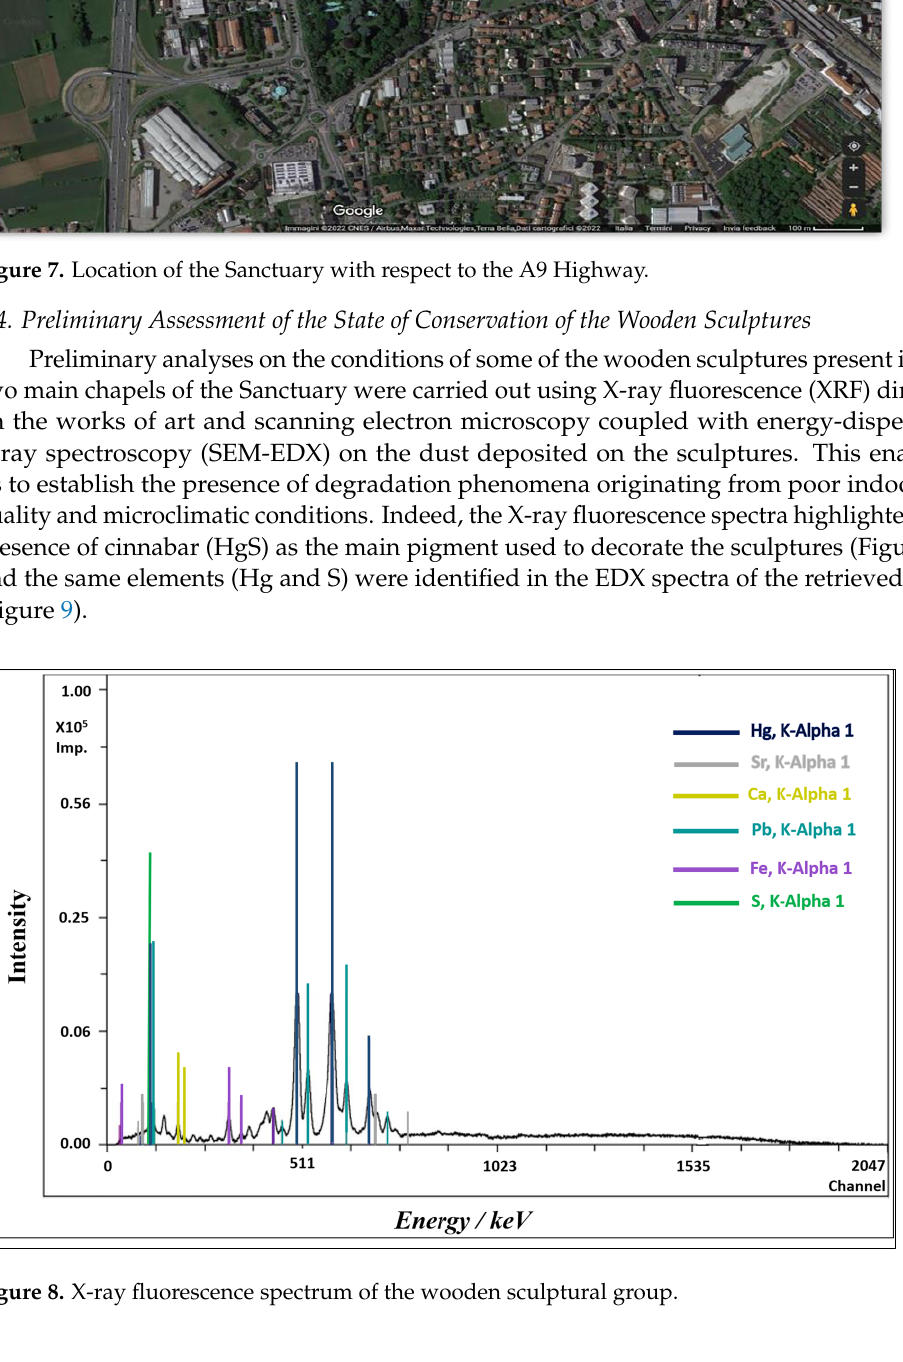
Figure 9. ( a ) SEM image of the dust deposited on the wooden sculptures (area = 0.80 mm × 0.60 mm, 400× magnification). ( b ) EDX spectrum of the image presented in ( a ). ( c ) Point image of the dust deposited on the wooden sculptures (Area = 0.04 mm × 0.03 mm, 7000× magnification). ( d ) EDX spectrum of the image presented in ( c ). Experimental parameters: accelerating voltage = 15 kV; working distance = 6500 µm; emission current = 65 mA; acquisition time = 150 s. SEM analysis of the dust deposited on the wooden sculptures highlighted the pres- ence of all the main constituents of atmospheric dust [27] including magnesium, sodium, calcium, chlorine, silicon, potassium, and iron. However, point analyses at greater mag- nifications enabled the detection of mercury, which is an element that is hardly ever found in concentrations above the instrumental SEM-EDX detection limits in atmospheric dust. The presence of this element is most certainly derived from the underlying substrate, which is represented by the wooden statue, highlighting the partial detachment of the pictorial film. The combined results of the two techniques indicate a poor state of conservation of the wooden sculptures. Considering that the powder was retrieved with the simple use of a brush, the fact that the same elements making up the substrate (identified thanks to the use of XRF) were also found in the deposited powder highlights the fragility of the artifact. The partial detachment of the pigment that was observed could be due to the chemical –